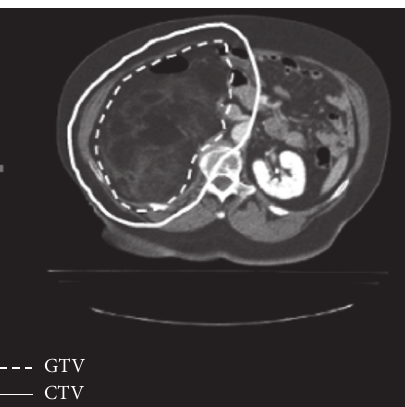
Figure 1: Gross tumor volume and the intended clinical target volume planned standardly in the preoperative setting.